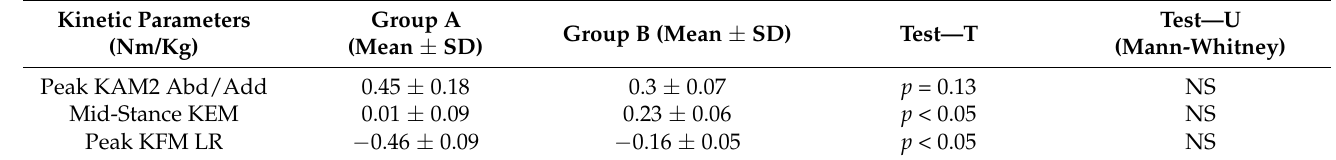
Table 7. Most significant kinetic parameters for both study groups. We report a weak significance in the mean extensor moment of the knee at the MS phase (Mid-Stance KEM), lower in Group A, and in the peak of the flexion moment of the knee at the LR phase (Peak KFM LR), which was higher in Group A. There was also a difference, not statistically significant, in the 2nd peak of the adductor moment of the knee (Peak KAM2 Abd/Add), which was slightly greater in the patients of Group A. LR: load-Response; MS: Mid-Stance; KAM: Knee Adduction Moment; KEM: Knee Extension